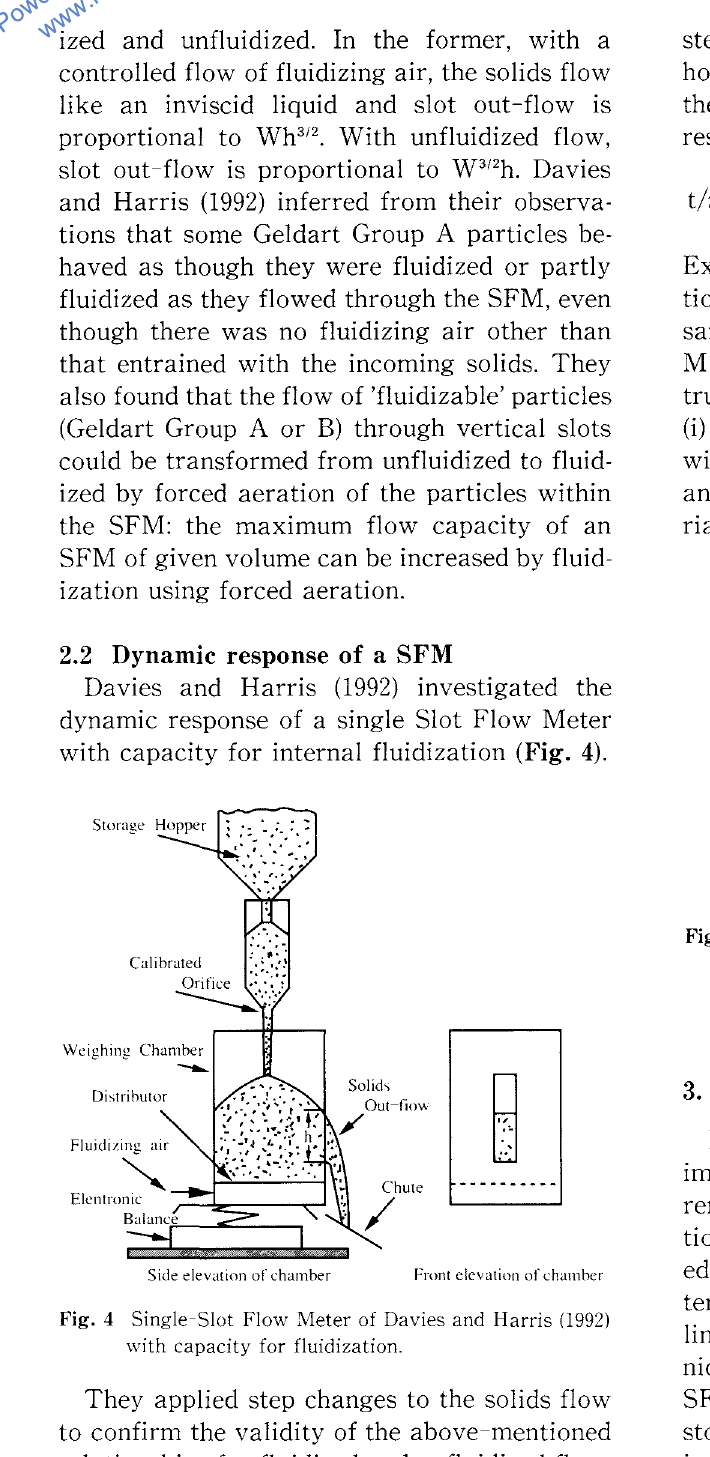
Fig. 4 Single-Slot Flow Meter of Davies and Harris (1992) with capacity for fluidization.